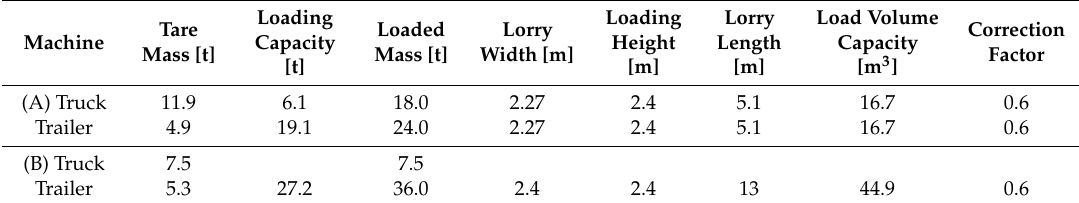
Table 3. Machine-related characteristics and dimensions considered within the loading and mass capacity calculations.